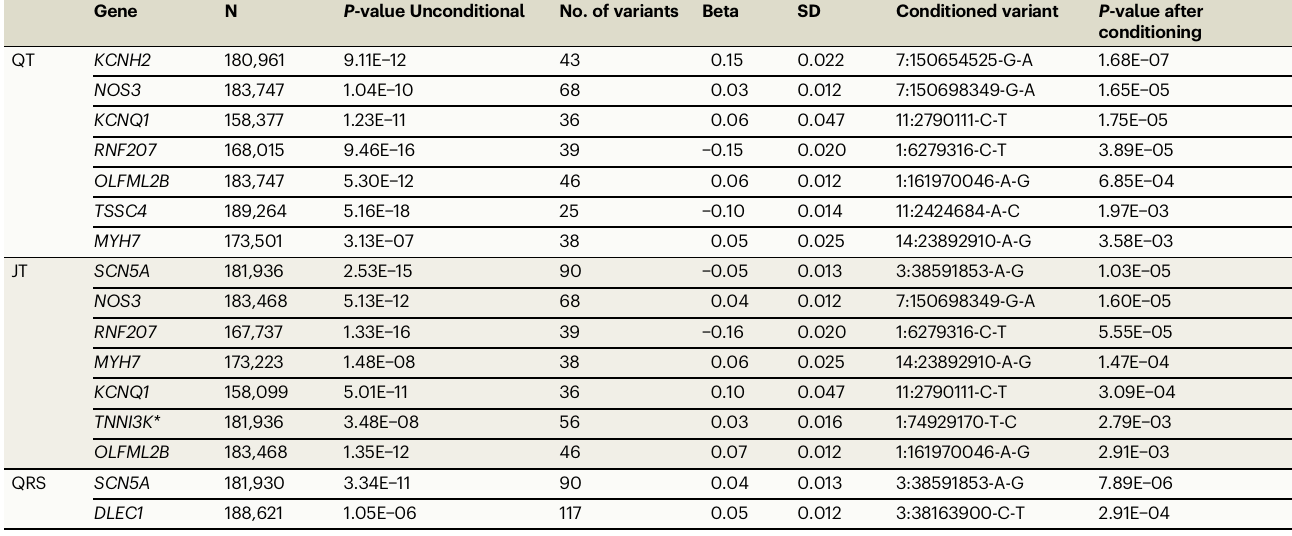
Table 2 | Signi fi cant genes from gene-based meta-analysis for each ECG trait following conditional analysis Gene N P -value Unconditional No. of variants Beta SD Conditioned variant P -value after